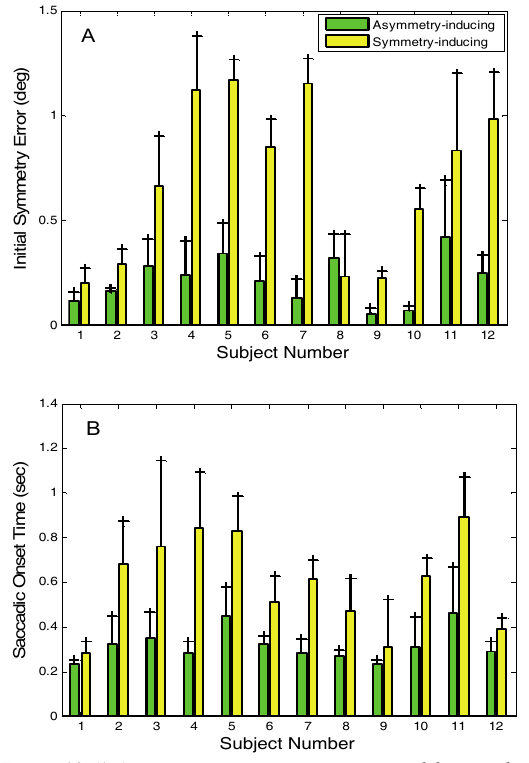
Figure 10 A) Average symmetry errors at onset of the initial saccade for asymmetry-inducing (green bars) and symmetry- inducing (yellow bars) saccades. B) Onset time in seconds of asymmetry-inducing (green bars) and symmetry-inducing initial saccades (yellow bars).